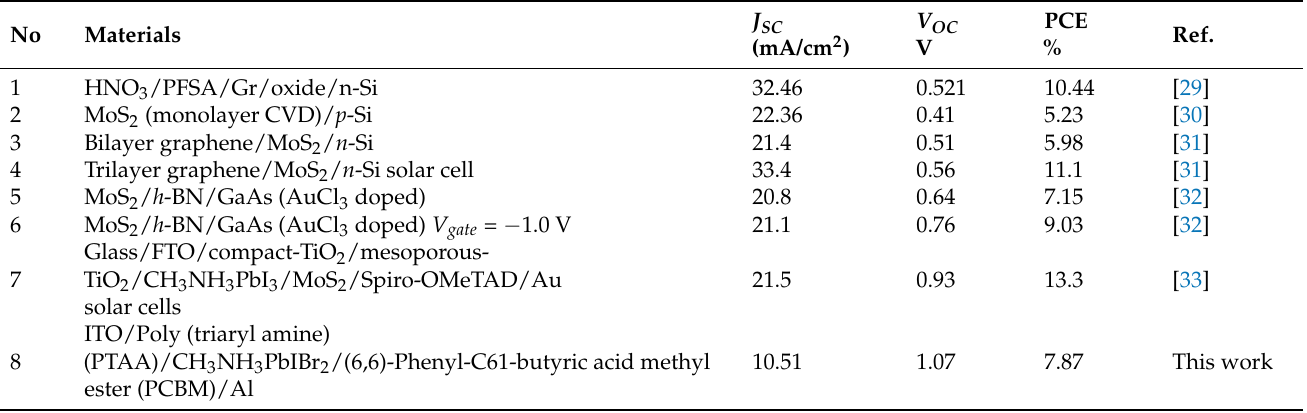
Table 1. Performance of solar cells.